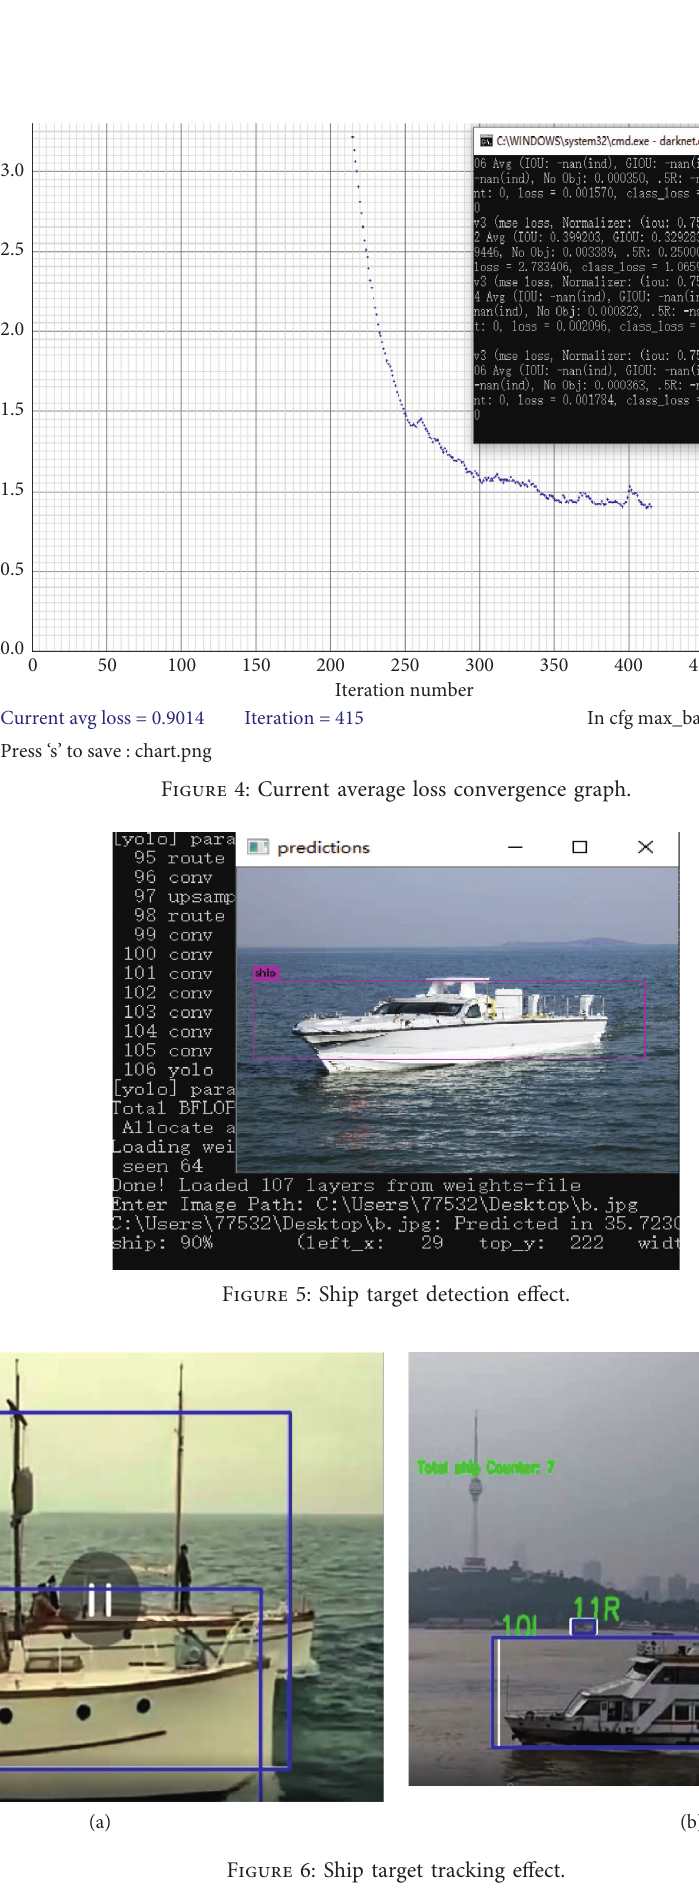
Figure 6: Ship target tracking